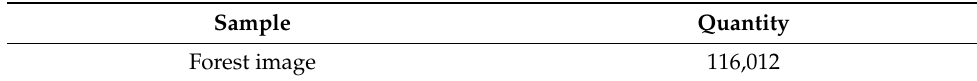
Table 2. Segmented aerial forest image.